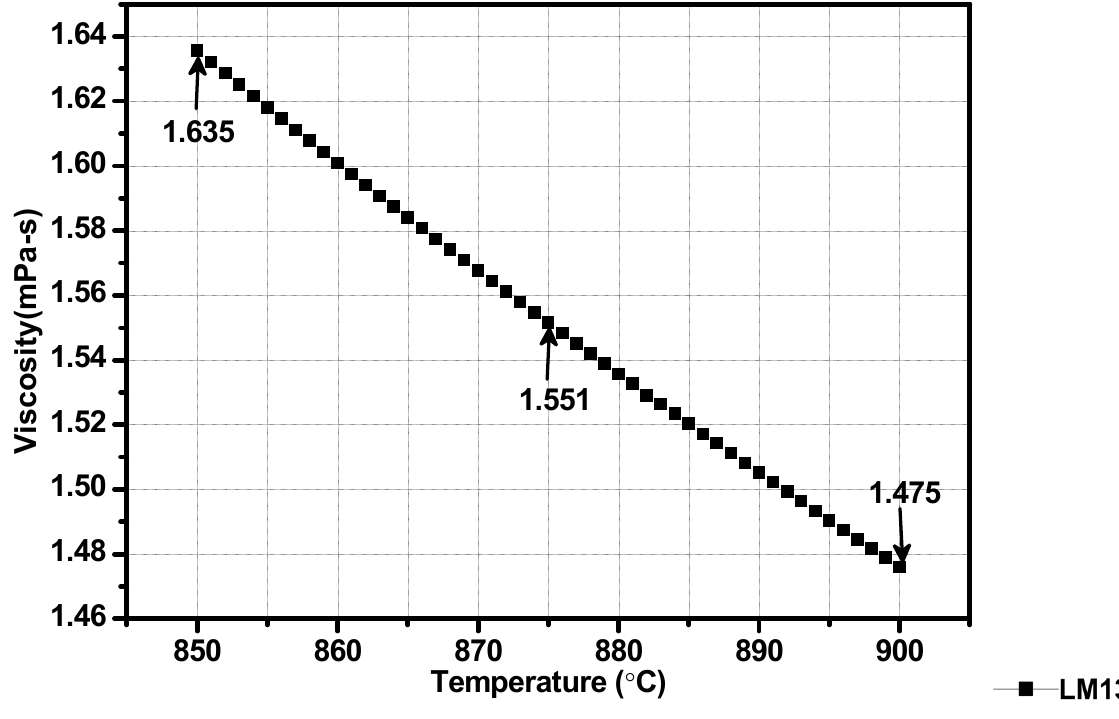
Figure 2. The e ff ect of foaming temperature on the viscosity of the LM13 alloy foams. Figure 2. The effect of foaming temperature on the viscosity of the LM13 alloy